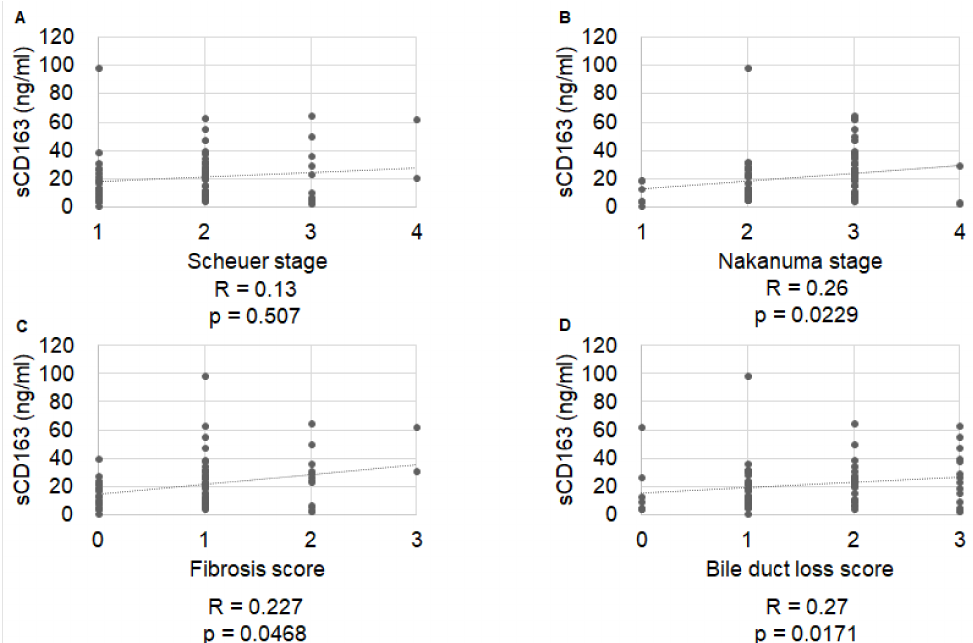
Figure 2. Correlation of serum CD163 levels with histological stage. ( A ) Scheuer stage, R = 0.13, p = 0.507; ( B ) Nakanuma stage, R = 0.26, p = 0.0229; ( C ) Nakanuma fibrosis score, R = 0.227 p = 0.0468;